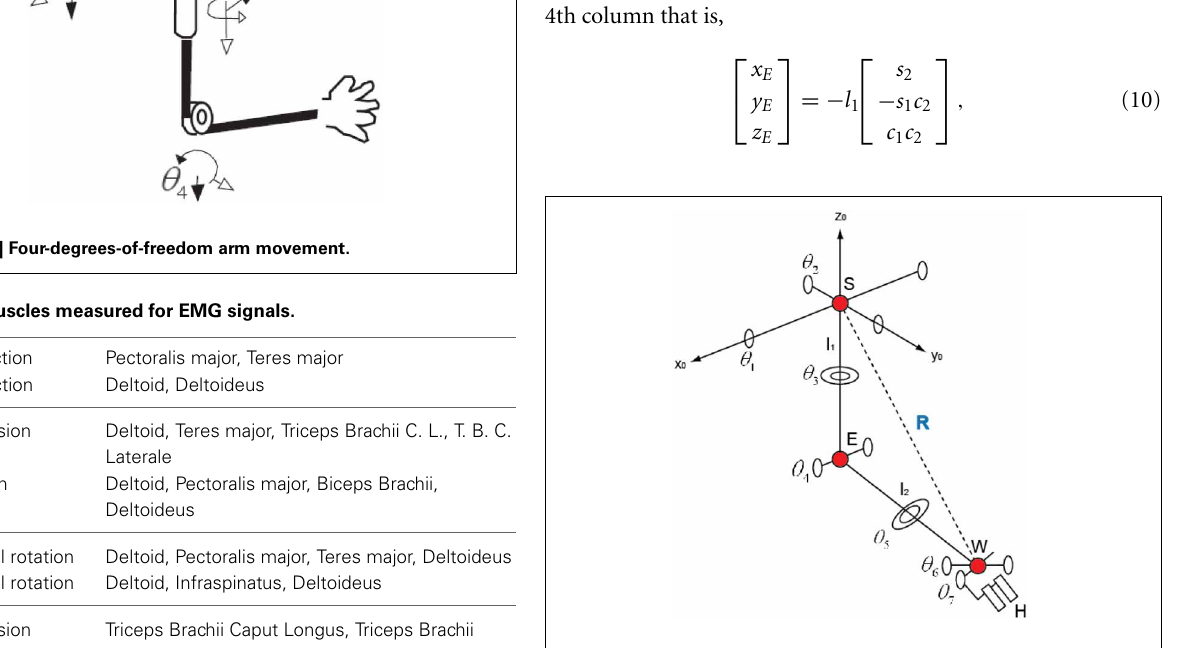
FIGURE 5 | The structure of the joints of a